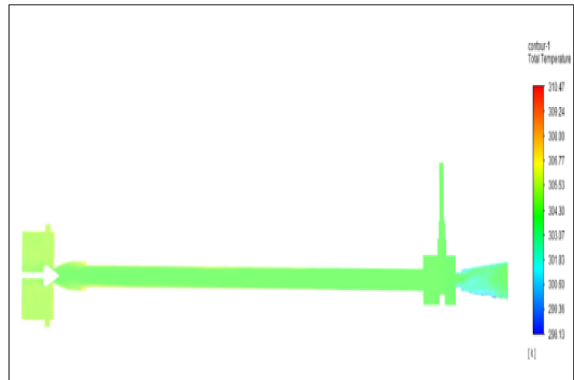
Figure 44. Brass at 12 bar.